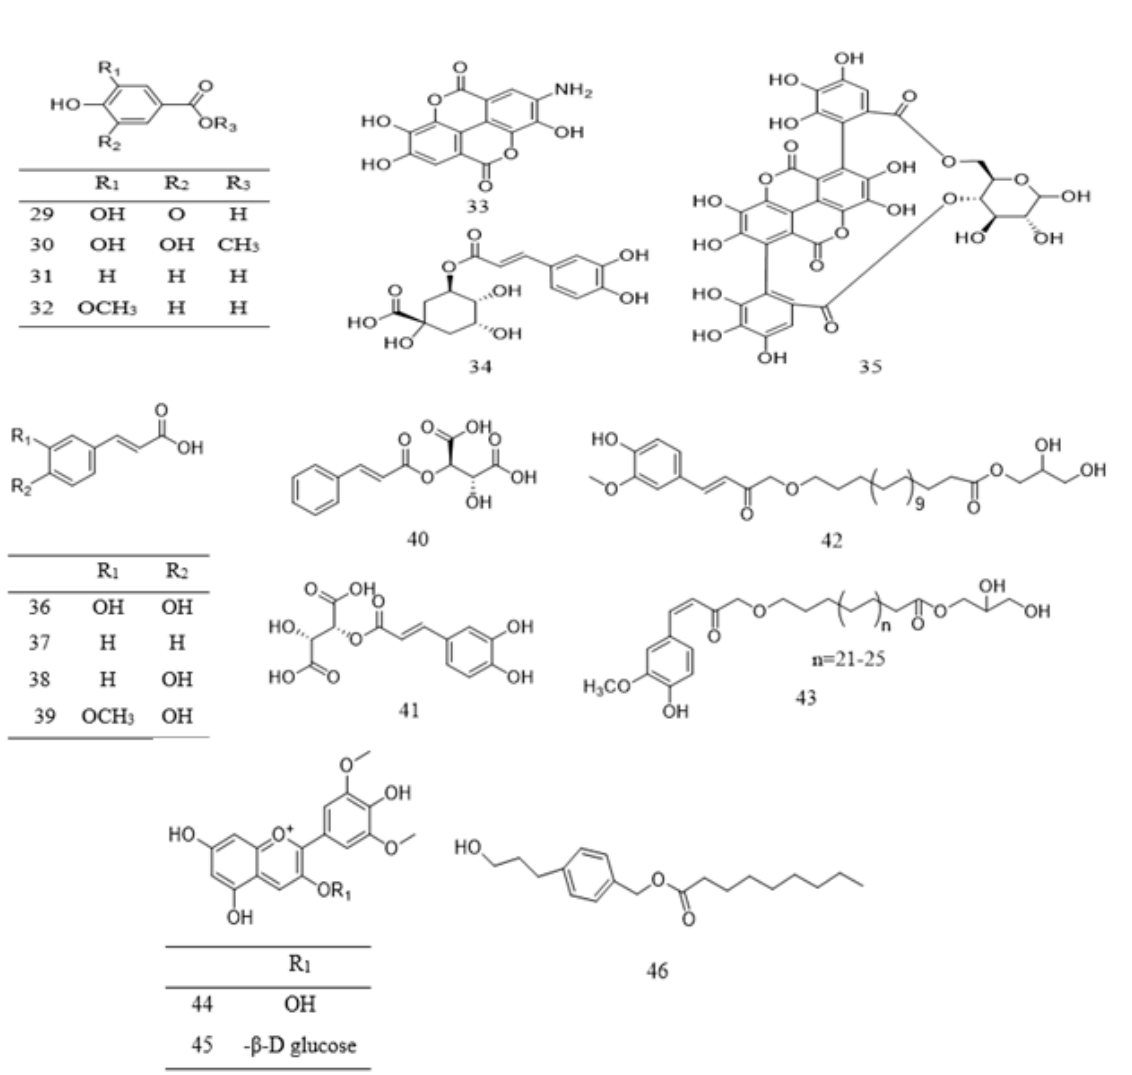
Figure 3. Structural formulas of polyphenolics 29 – 46 , as previously listed in Table 2.